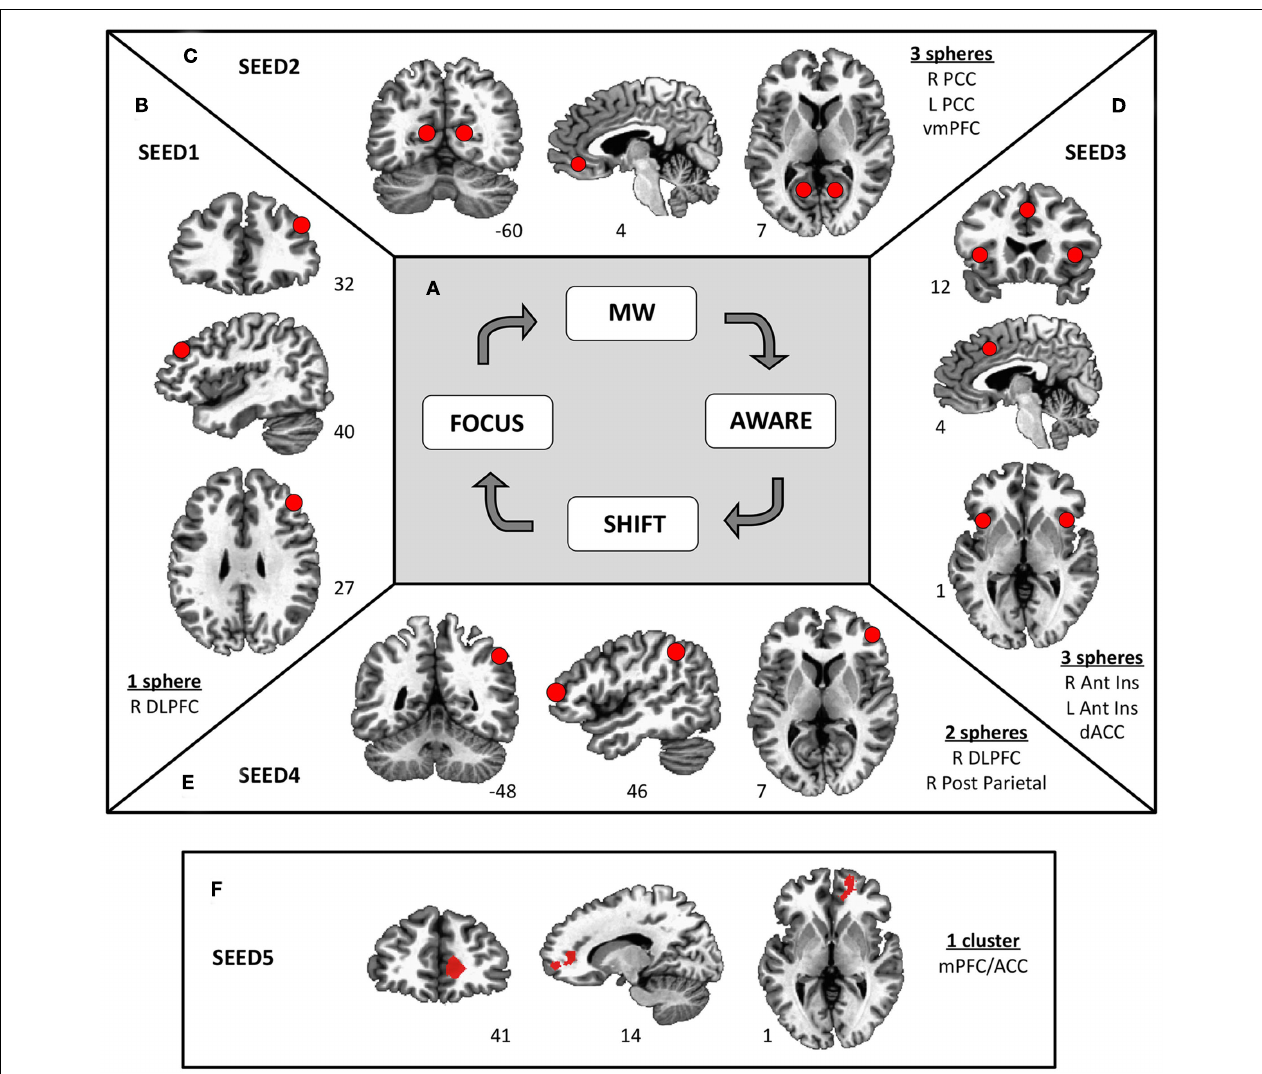
constructed around the right dlPFC (SEED1). (C) On the activations from the MW phase, ROIs were constructed around the ventromedial PFC and bilateral posterior cingulate cortex (SEED2). (D) On the activations from the AWARE phase, ROIs were constructed around the dorsal ACC and bilateral anterior insula (SEED3). (E) On the activations from the SHIFT phase, ROIs were constructed around the right dlPFC and the right posterior parietal lobule (SEED4). (F) A cluster in the medial PFC/ACC was found to be less active during the SHIFT condition as participants’ meditation experience increased (see Appendix).To further understand this finding, this cluster is included as